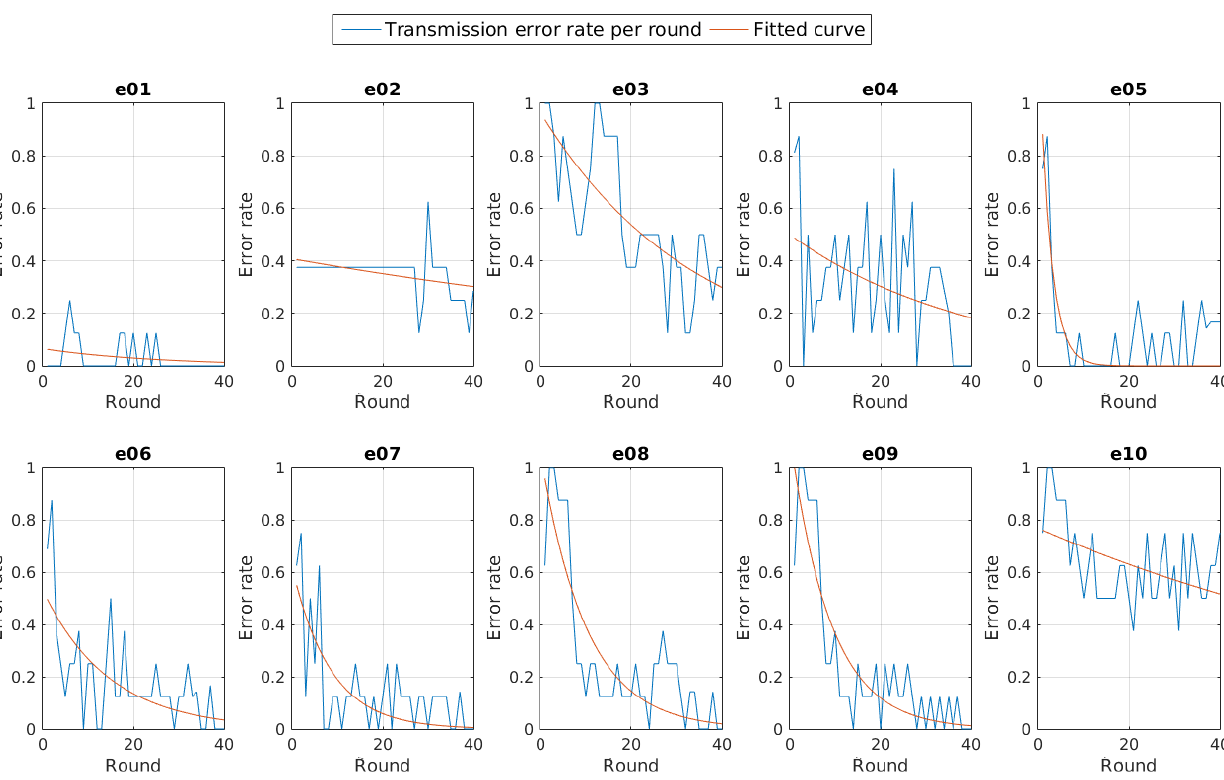
Figure 12. Round transmission error rate per